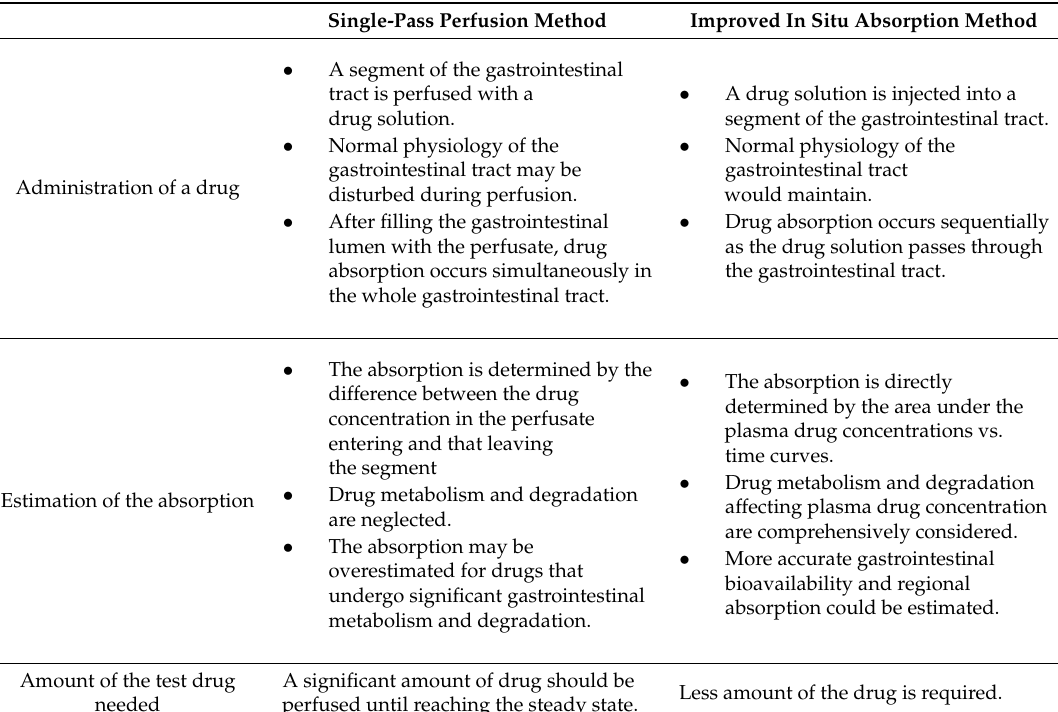
Table 5. Comparison of the improved in situ absorption method and the single-pass perfusion method for evaluation of the regional